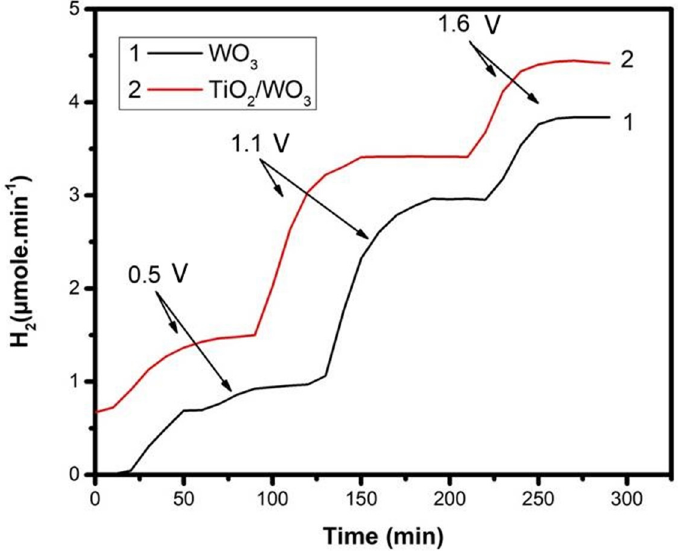
Figure 7. Variation of the photoelectrocatalytic hydrogen production rate by applying various electric biases. Biases are marked on the graph, and they are expressed in volts vs. Ag / AgCl electrode. The two curves correspond to the two photoanodes.